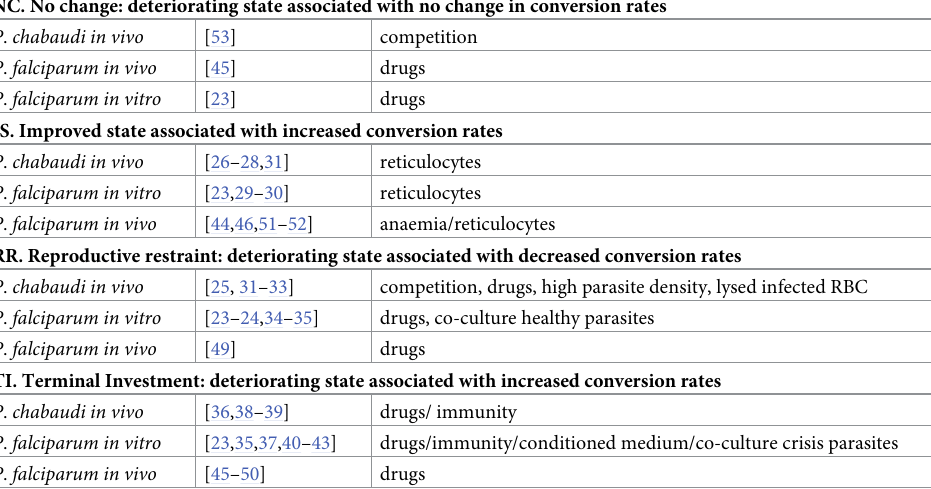
TI. Terminal Investment: deteriorating state associated with increased conversion